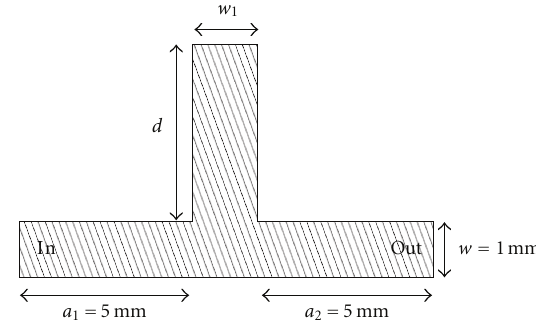
Figure 12: The performance of a microstrip T-junction to produce a transmission zeros.